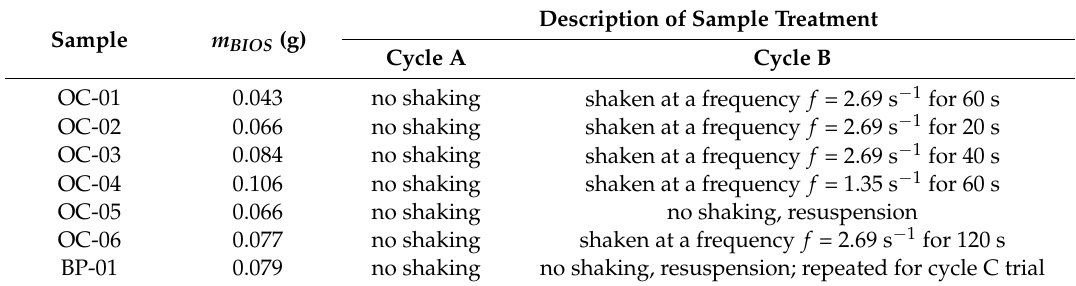
Table 1. Measured dry weights and descriptions of sample treatments for each